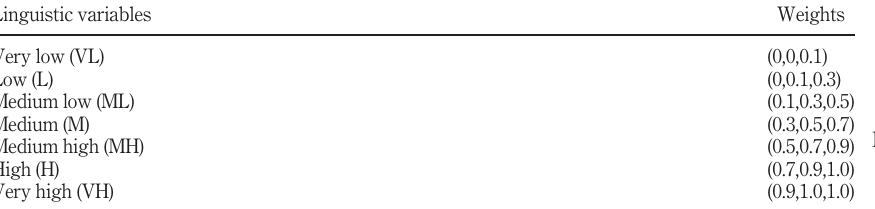
Table 3. Importance of weight